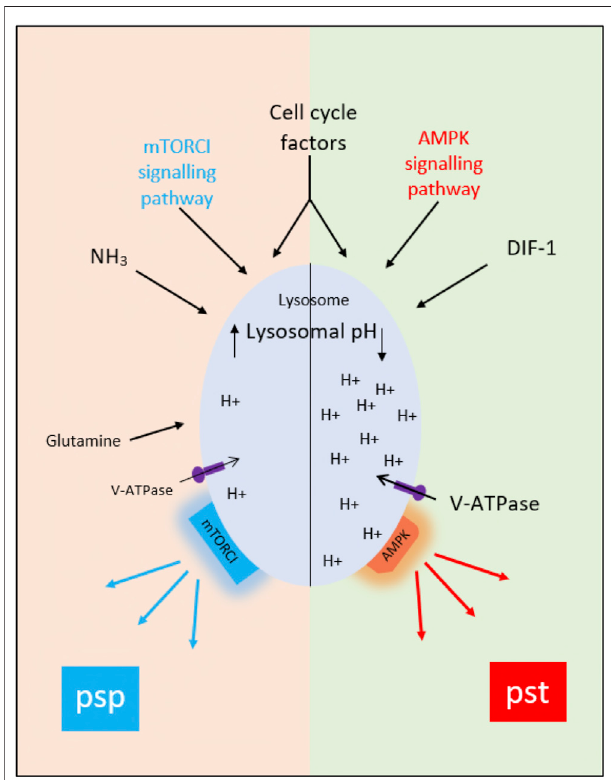
FIGURE3| Theproposedroleofacidic vesicle pH(pHv) incontrolofthe prestalk and prespore pathways at themoundstage ofdevelopment.Multiple factors including AMPK and mTORC1, cell cycle stage at the time of starvation, glycogen content, V-ATPase activities, cell adhesion and cell movement probably contribute to the division of a population of aggregated amoebae into those with acidi fi ed acidic vesicles (right-hand side of diagram). and those with neutralised acidic vesicles (left-hand side of diagram). We suggest that AMPK remains activated in the former group of cells, leading to continued prestalk gene expression, whereas it is downregulated in the latter group of cells and mTORC1 activated, initiating prespore gene expression.